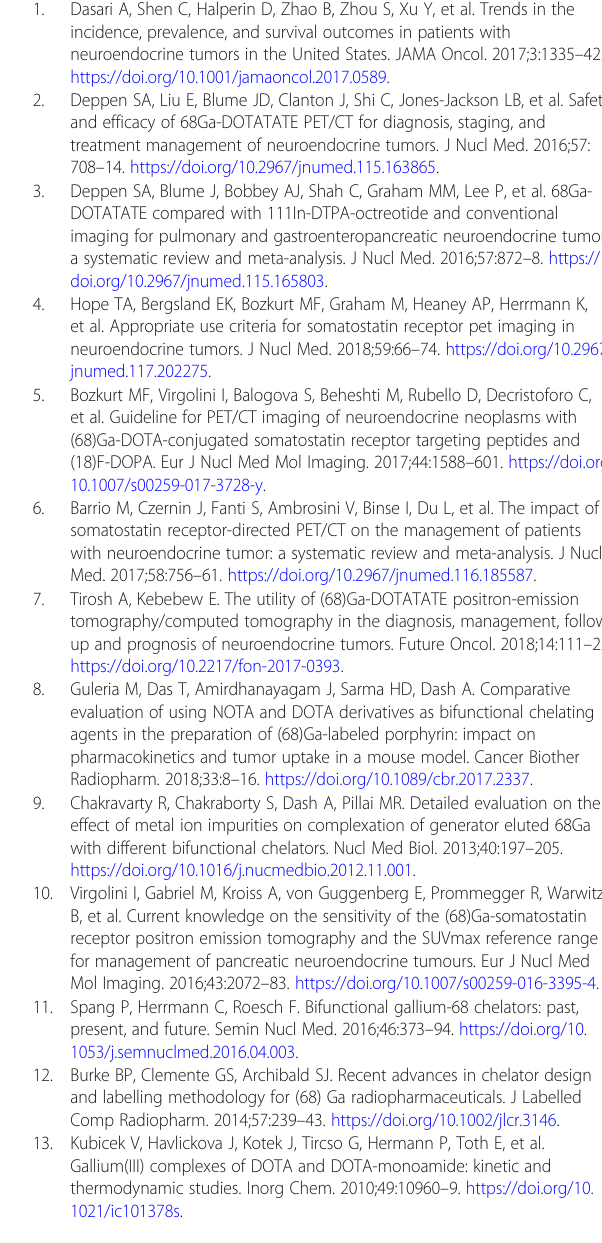
Additional file 1: Figure S1. LC-MS spectra for precursor NOTA-TATE. Additional file 2. Representative HPLC profiles of 68 Ga-DOTA-TATE (A) and 68 Ga-NOTA-TATE (B) with retention times of 11.8±0.08 min and 12.1± 0.05 min,